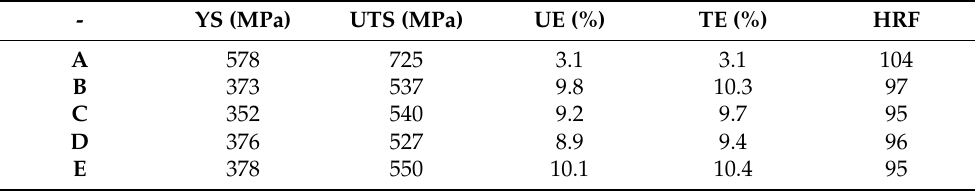
Figure 6. Tensile test of the Al-Ni-Cu alloy before and after solution treatment: ( a ) macroview of the fracture specimen and ( b ) stress–strain curve. Table 4. Tensile properties and hardness of the Al-Ni-Cu alloy before and after solution